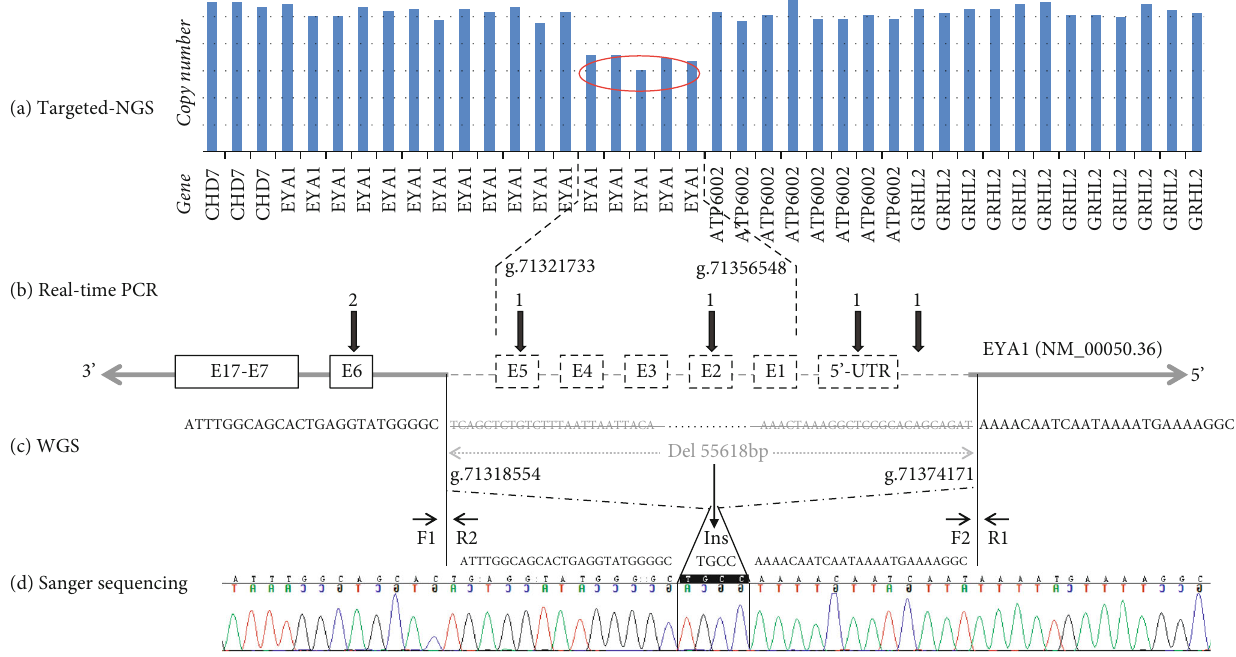
Figure 2: The process of identifying CNV. (a) The red oval indicates the region of deletion detected by targeted NGS. (b) Results of real-time PCR: 1 and 2 indicate copy number; black arrows: primer position; E: exon; left grey arrow: the 3 ′ -end; right grey arrow: the 5 ′ -end. (c) Grey words: region of deletion; F and R: forward and reverse primer; Ins: insertion. (d) Sequence diagram of 244bp PCR product. 4 bases between the two black vertical lines were additional